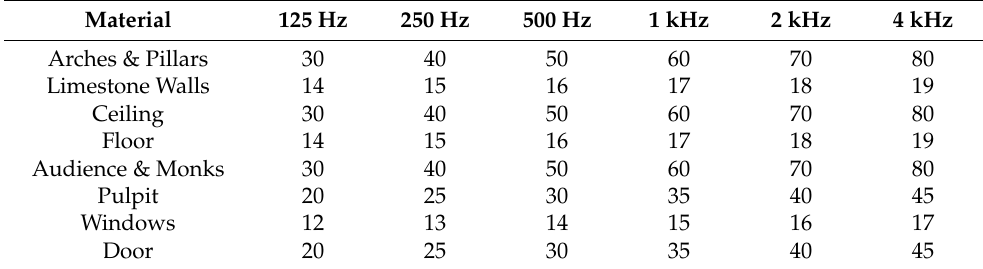
Table 4. Scattering coefficients used in final model [34].